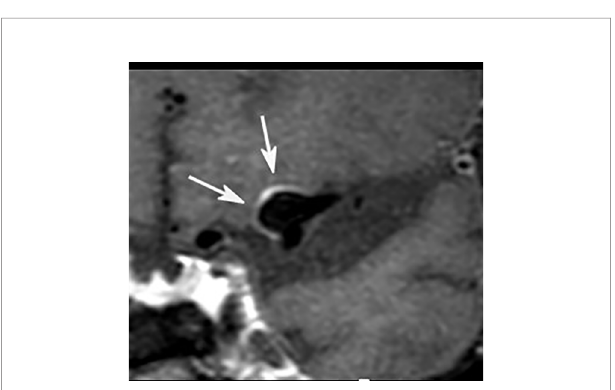
FIGURE 1 | Digital subtraction angiography of the brain with injection in the right internal carotid artery in a patient with varicella-zoster vasculitis (left). Multiple stenoses in the M1 segment of the right middle cerebral artery were found (arrows). 3T MR vessel wall imaging (right) shows strong contrast enhancement of the corresponding segments (arrows). The inset shows a transverse section through the proximal M1 segment with circumferential wall enhancement